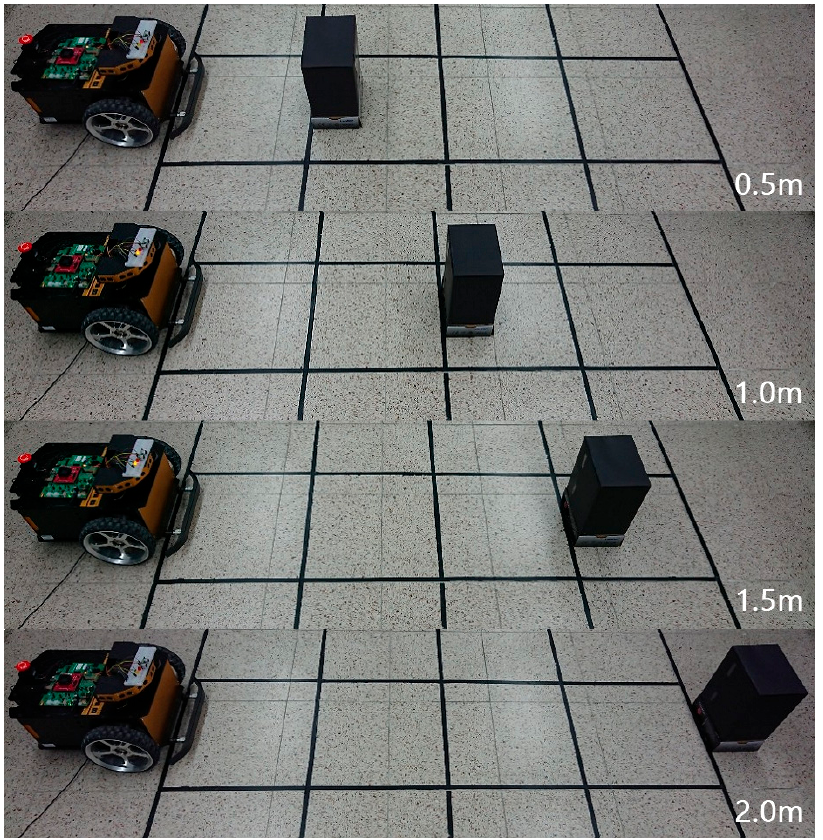
Figure 7. State when detecting the distance.